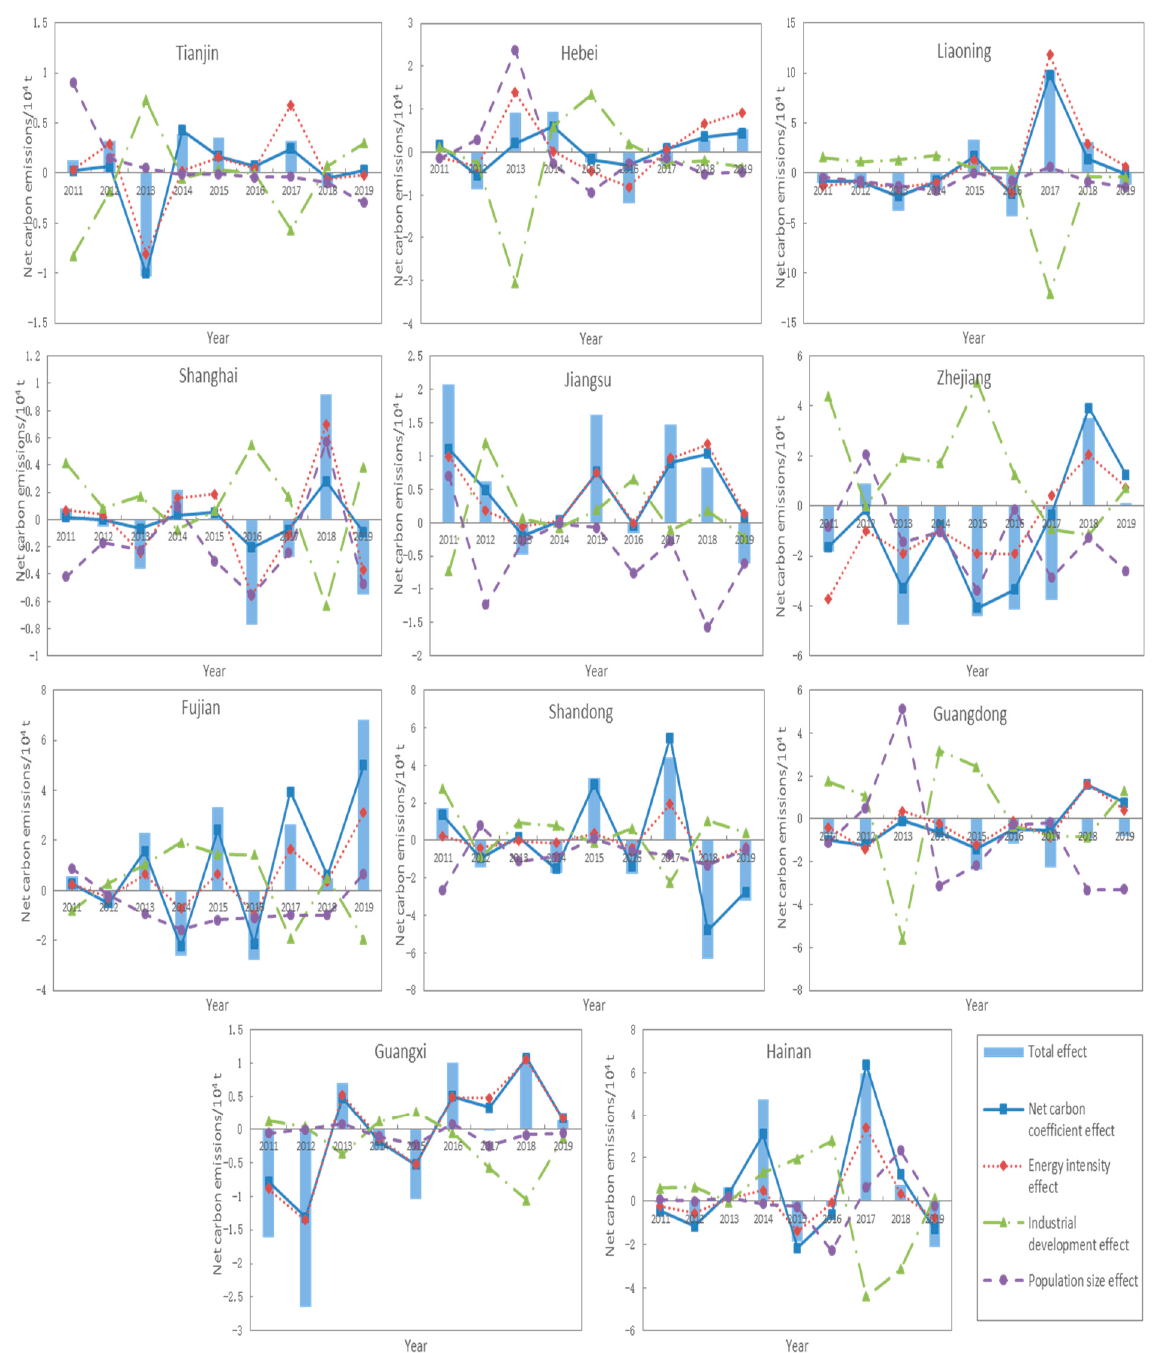
Figure 4. Decomposition results of net carbon emissions from offshore fishing in China’s coastal provinces from 2010 to 2019.